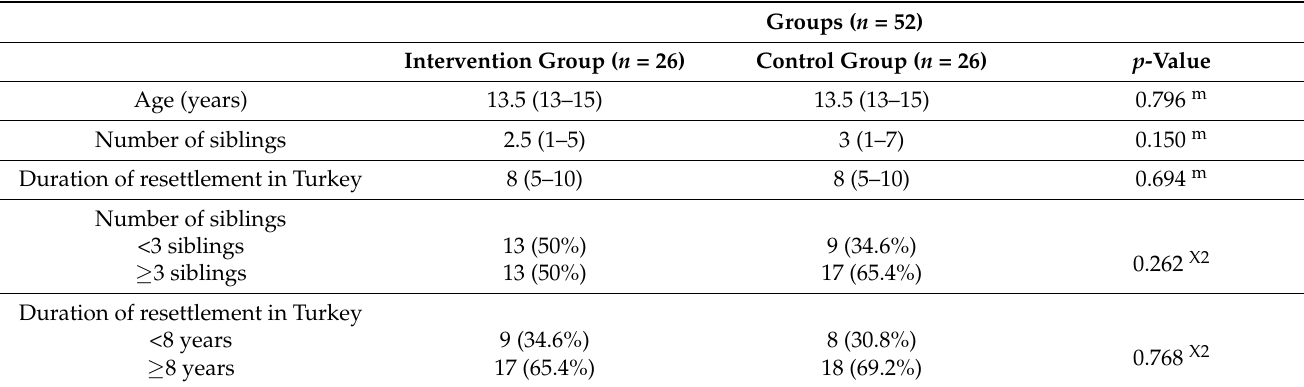
Table 4. General characteristics of the intervention and control